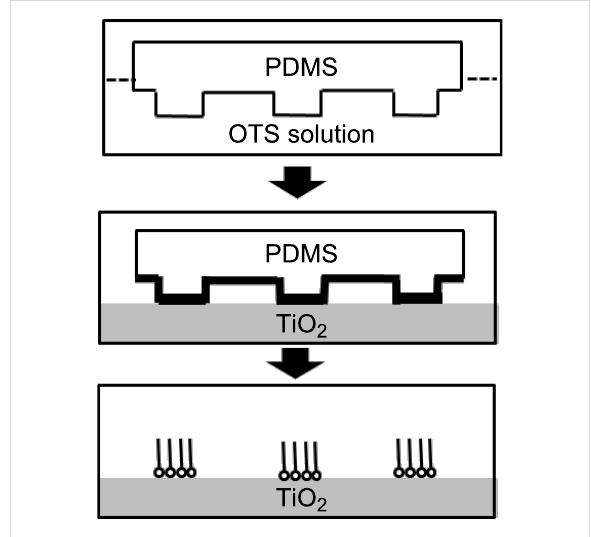
Figure 2: Patterning of SAMs on titanium dioxide by the microcontact printing